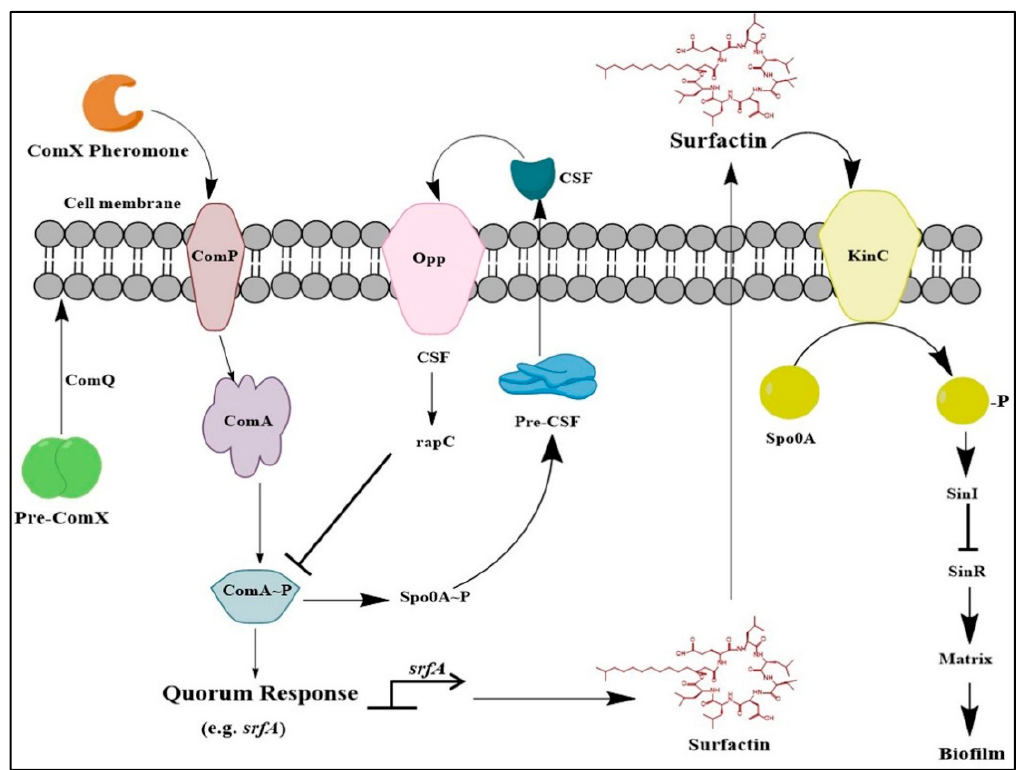
Figure 2. General pathway that regulates the transcription of srfA operon, which involves extracellular peptide regulated quorum sensing in B . velezensis and B . subtilis . T-bars show the negative regulation of protein interactions; the bent arrow indicates the function of the promoter.